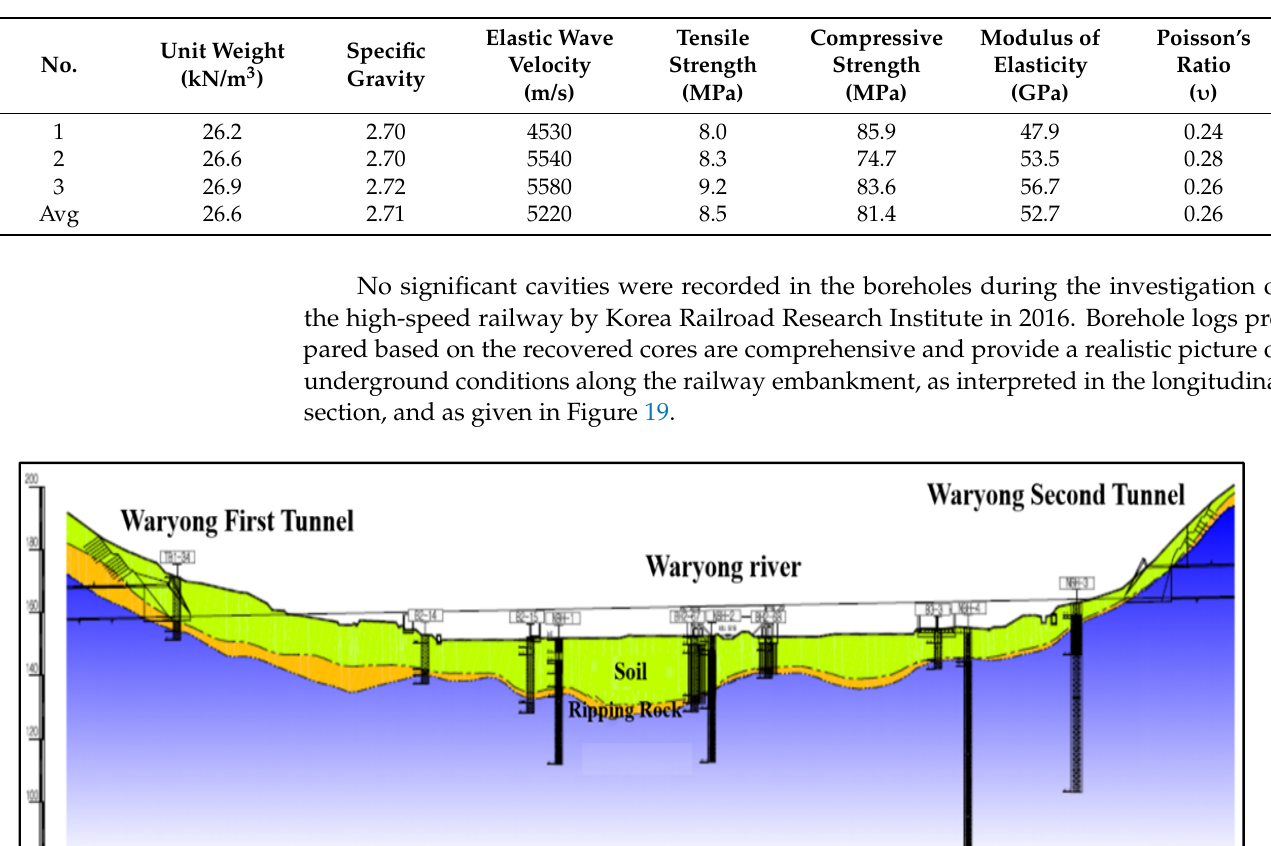
Table 5. Mechanical Properties of Limestone Present in the Study Area.